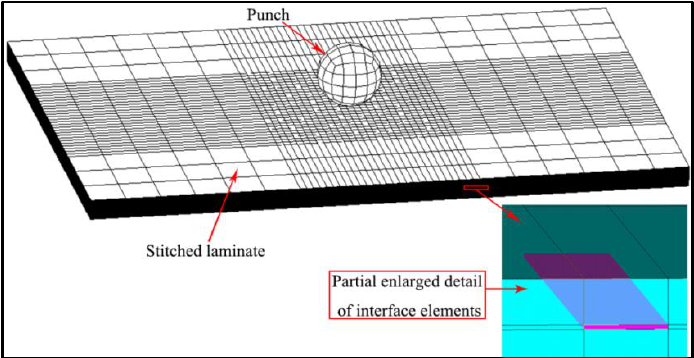
Figure 4. Finite element model of the stitched laminate.